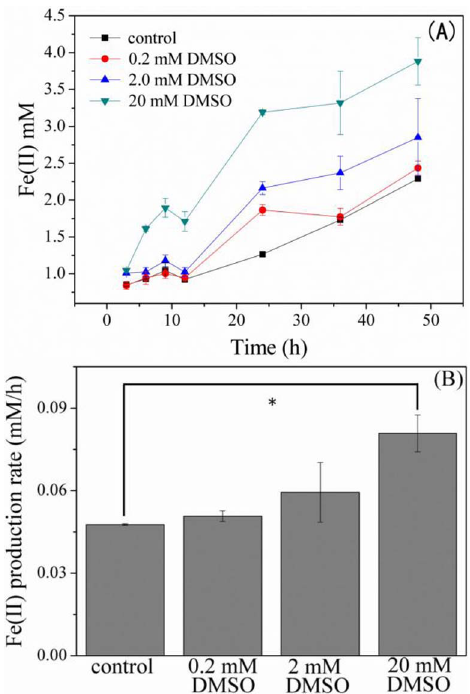
Figure 1. HFO reduction in the presence of DMSO. (A) HFO reduction by S. oneidensis MR-1 with different concentration of DMSO. (B) Fe(II) producing rate after 48 hours reduction of HFO. Resting cells were incubated with 20 mM HFO and DMSO with various concentra- tions. The data are average of triple samples and error bars represent standard deviation. Asterisk indicates significant difference, p , 0.05.